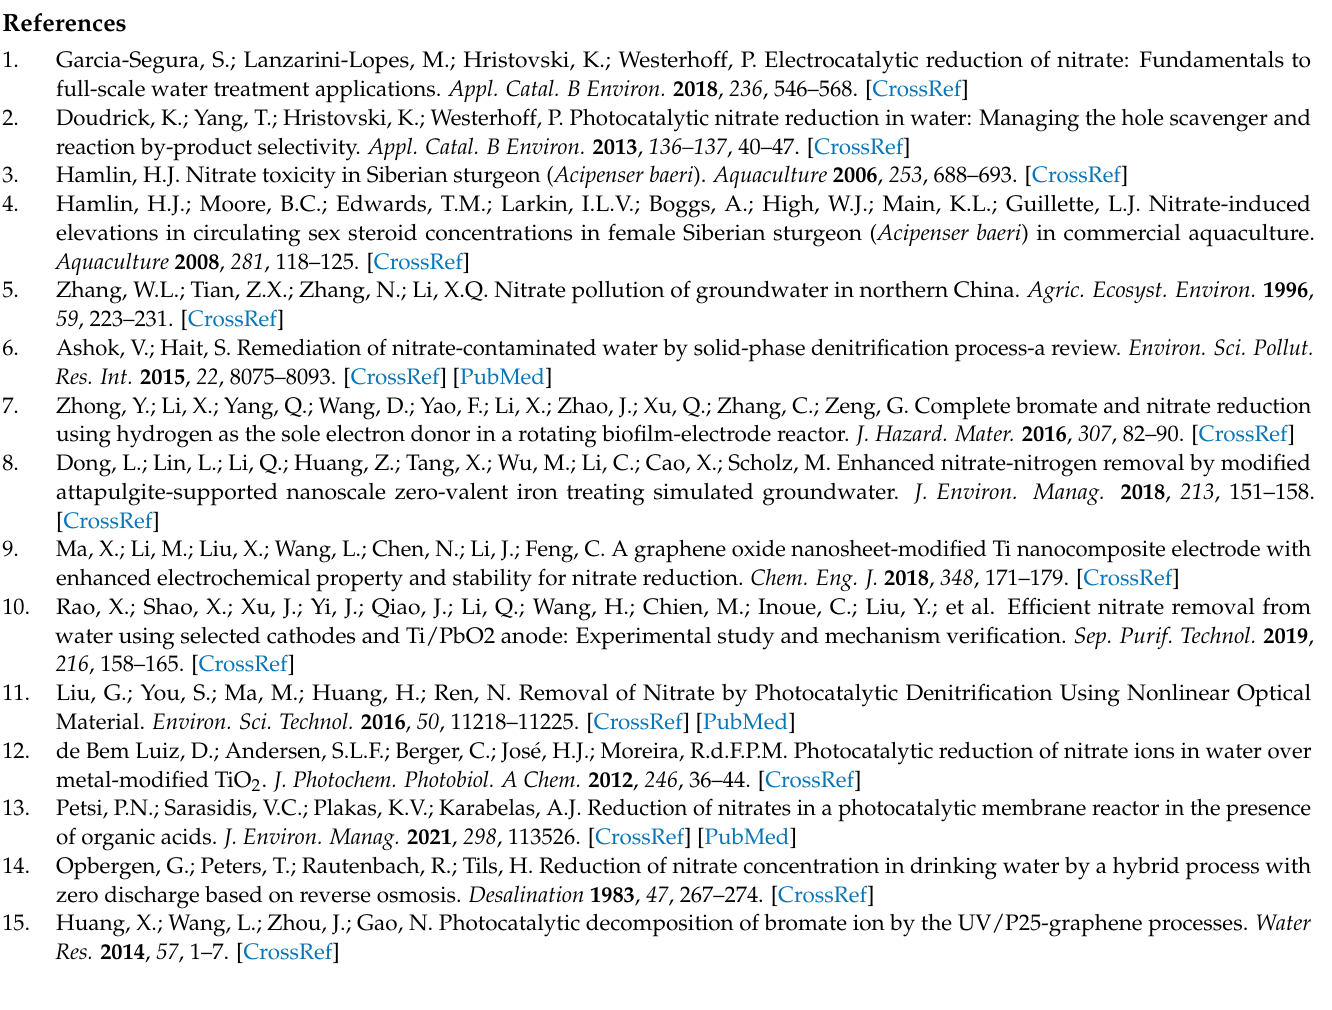
Figure S4: The ln(C0/C) value versus reaction time at various solution pH in the UV/C2O42–/Fe 3+ systems; Figure S5: Formation of primary products at different UV lamp power during reduction of NO 3 − in the UV/C2O42–/Fe 3+ systems; Figure S6: Formation of primary products at various initial NO 3 − levels during reduction of NO 3 − in the UV/C2O42–/Fe 3+ systems; Figure S7: The variation of solution pH with time in the UV/C2O42–/Fe 3+ systems; Table S1: The characteristics of simulated groundwater; Table S2: Kinetic parameters of NO 3 − reduction at various Fe 3+ levels; Table S3: Kinetic parameters of NO 3 − reduction at different initial solution pH; Table S4: Kinetic parameters of NO 3 − reduction at different UV light